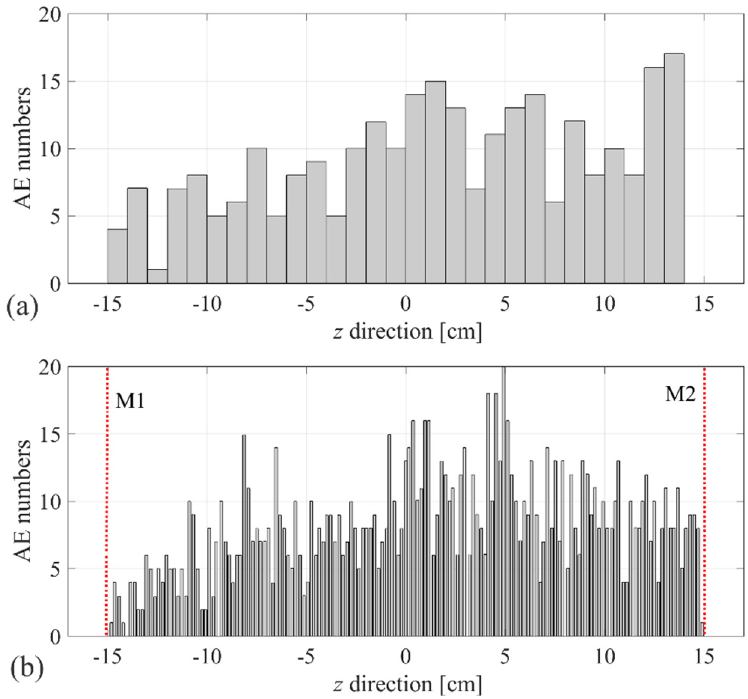
Figure 9. ( a ) AE sources distribution along the z direction: Lunitek system (see Figure 4); ( b ) Mistras system between M1 and M2 sensors.